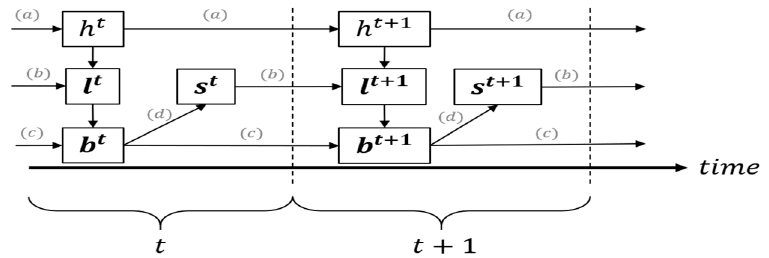
Figure 2. Order of events throughout sensing epochs.